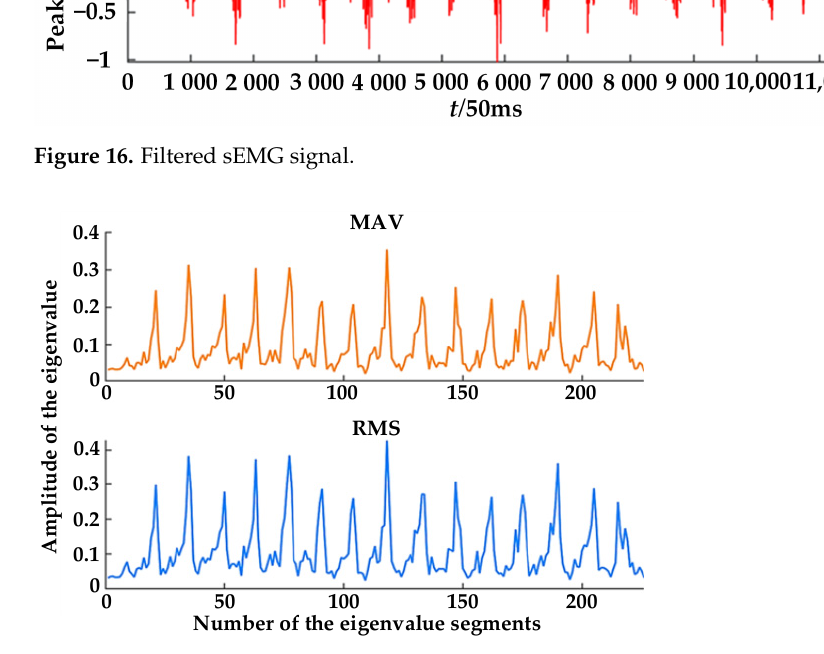
Figure 17. Feature extraction results.